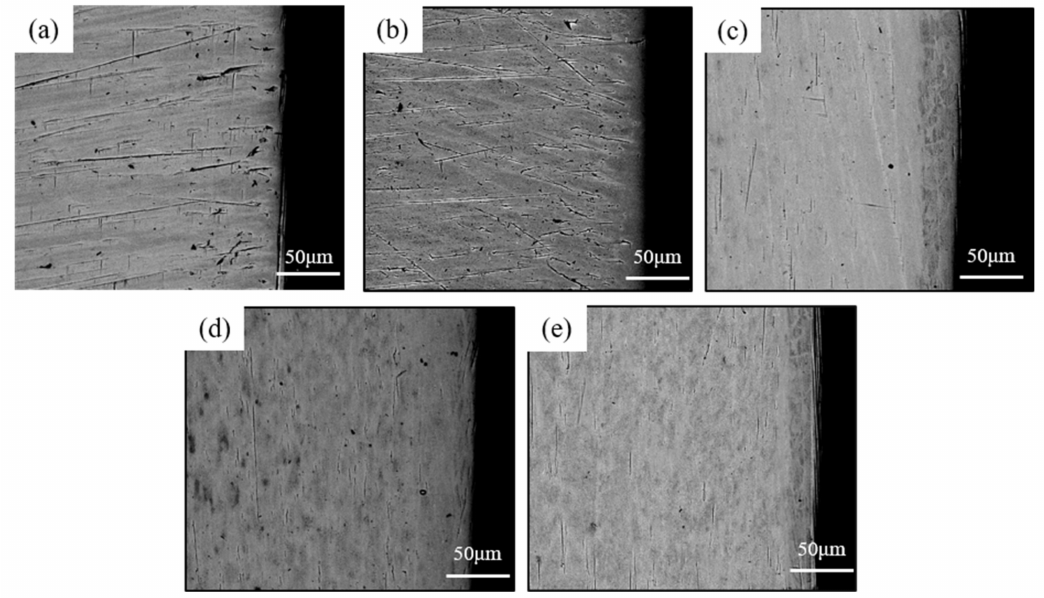
Figure 10. SEM morphology of a cross-section of a TA2 alloy sample after low-temperature nitriding. ( a ) 0% deformed, ( b ) 20% deformed, ( c ) 40% deformed, ( d ) 60% deformed, and ( e ) 80%